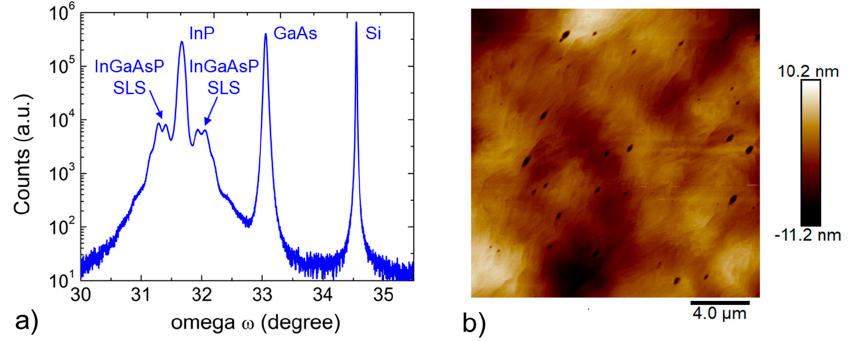
Figure 4 . ( a ) ω -2 θ scan and ( b ) AFM scan of the final epitaxial structure. Figure 4. ( a ) ω -2 θ scan and ( b ) AFM scan of the final epitaxial